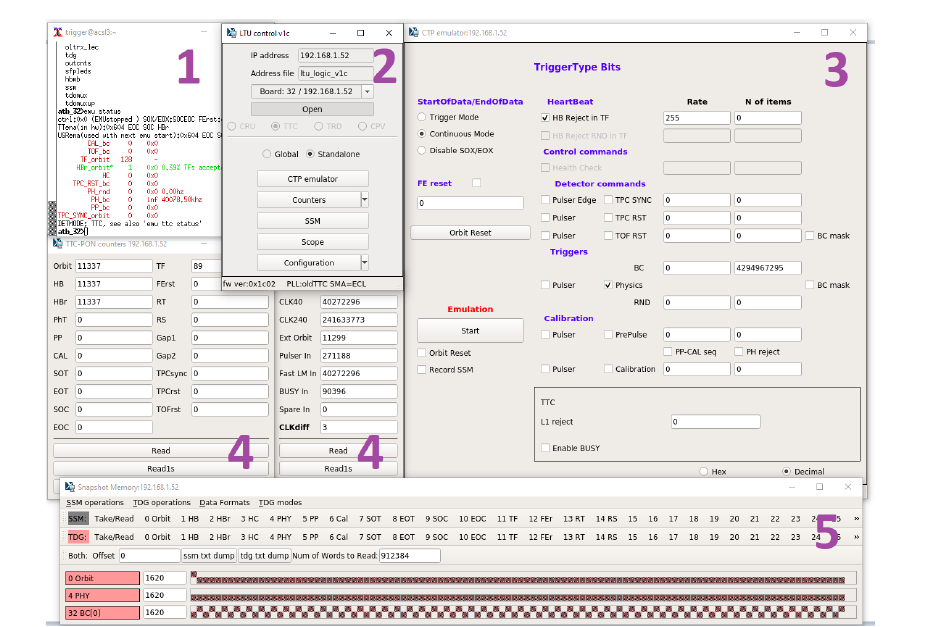
Figure 4. Main elements on the CTP FPGA